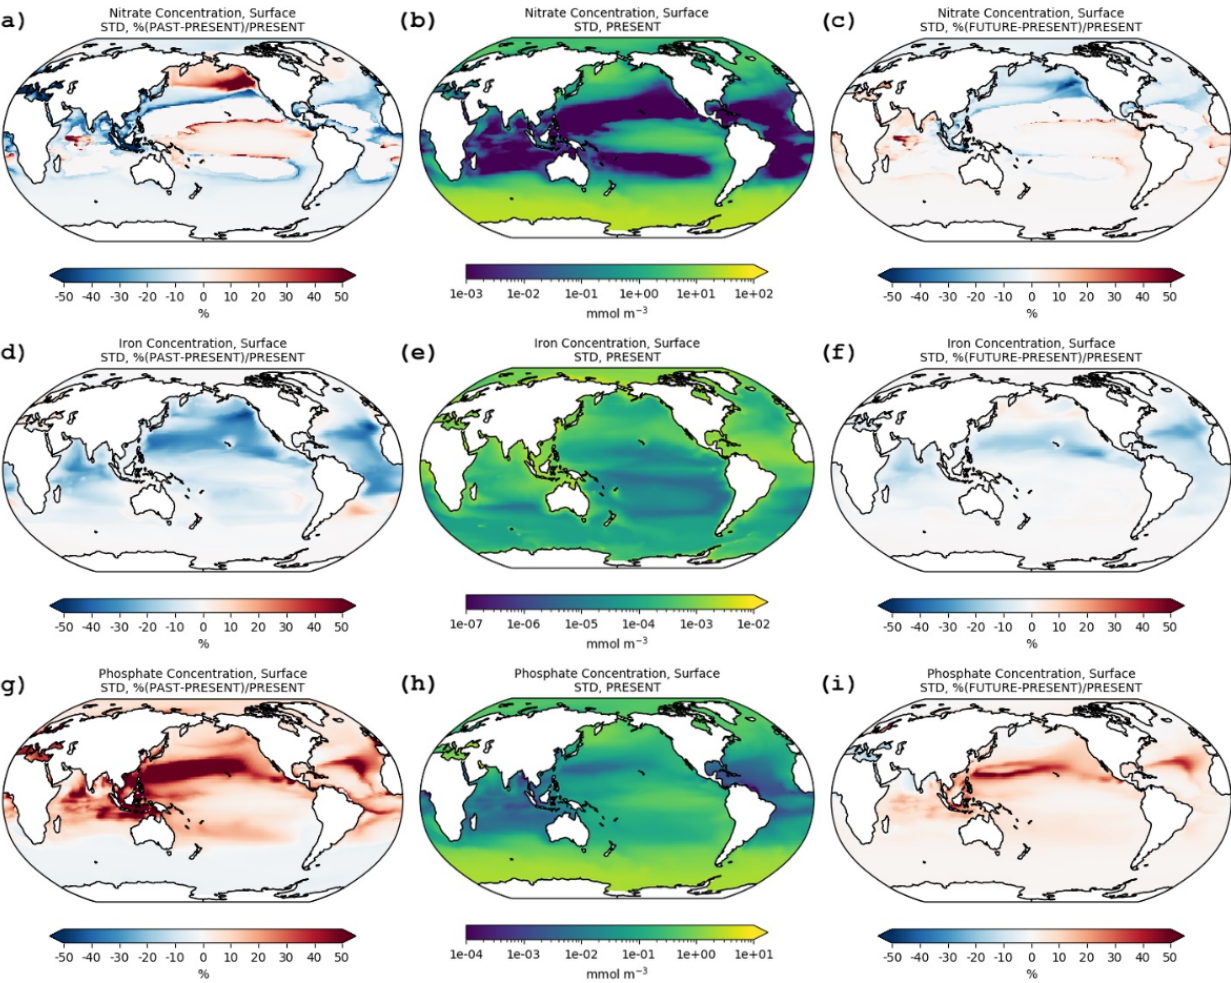
Figure 2. Surface oceanic concentrations (mmolm − 3 ) of nitrate (b) , iron (e) , and phosphate (h) as calculated by the model for PRESENT (b, e, h) for the STD simulation, and the respective relative differences (%) compared to PAST (a, d, g) and FUTURE (c, f, i)